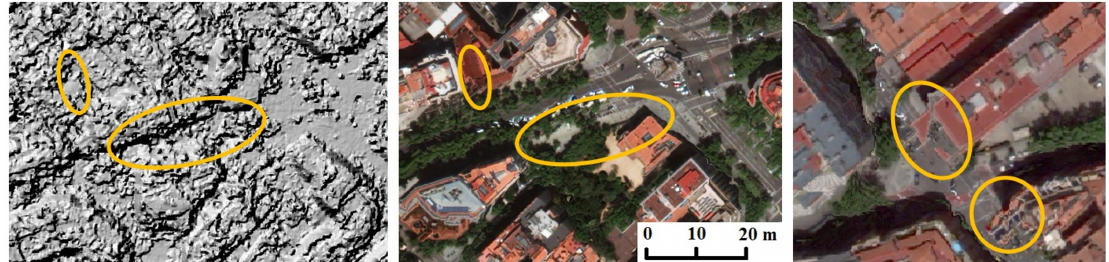
Figure A3. Artifacts and distortion effects in the true orthophoto (center and right images) caused by the high roughness of the image-matched DSM (left